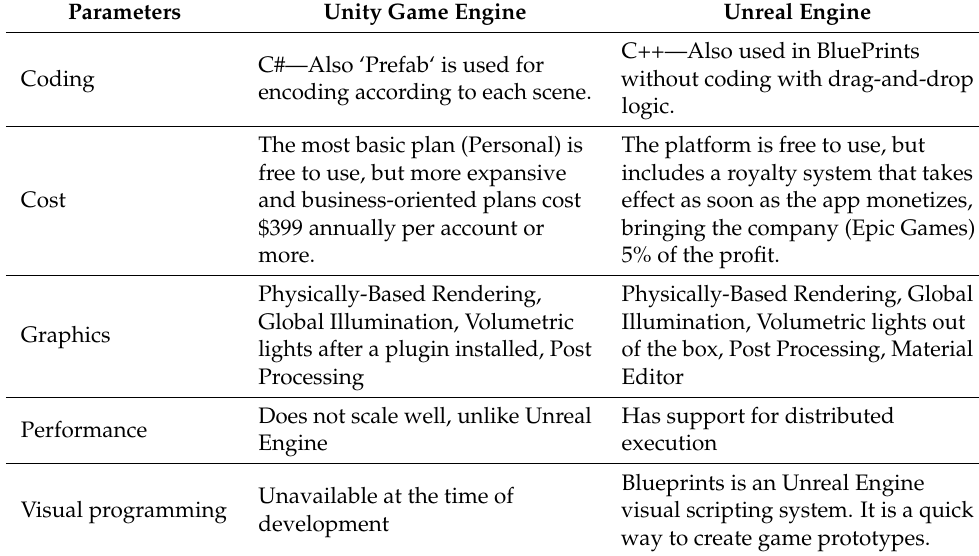
Table 1. Comparison of environments for creating virtual student learning tools.